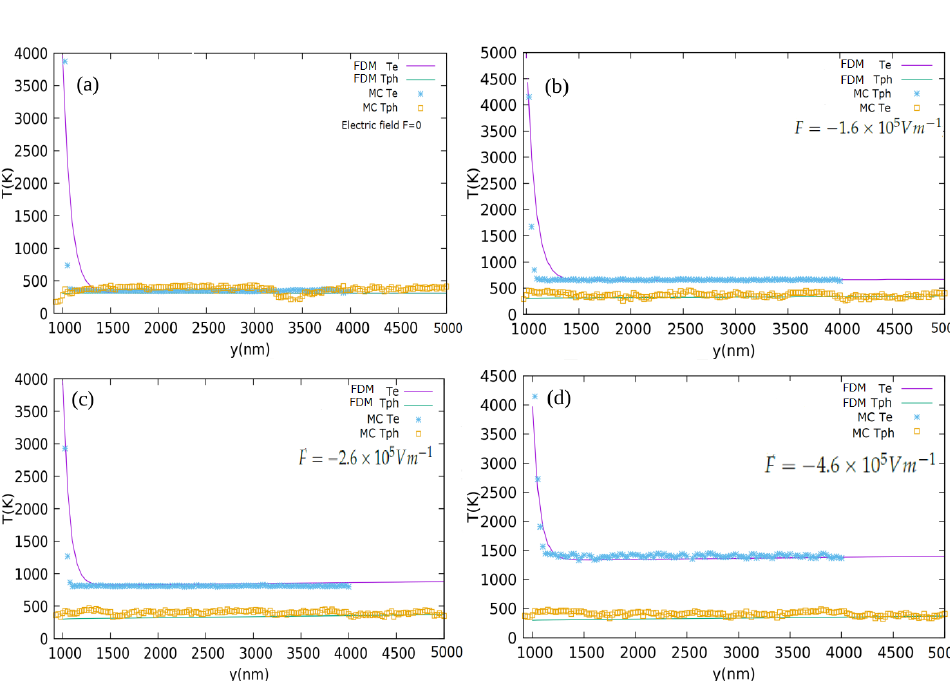
Figure 2. Electron and phonon temperatures ( T e and T ph ) along the y direction using MC and the two step model (FDM) for electric fields ( a ) (cid:126) F = 0, ( b ) (cid:126) F = − 1.6 × 10 5 Vm − 1 ˆ y , ( c ) (cid:126) F = − 2.6 × 10 5 Vm − 1 ˆ y and ( d ) (cid:126) F = − 4.6 × 10 5 Vm − 1 ˆ y